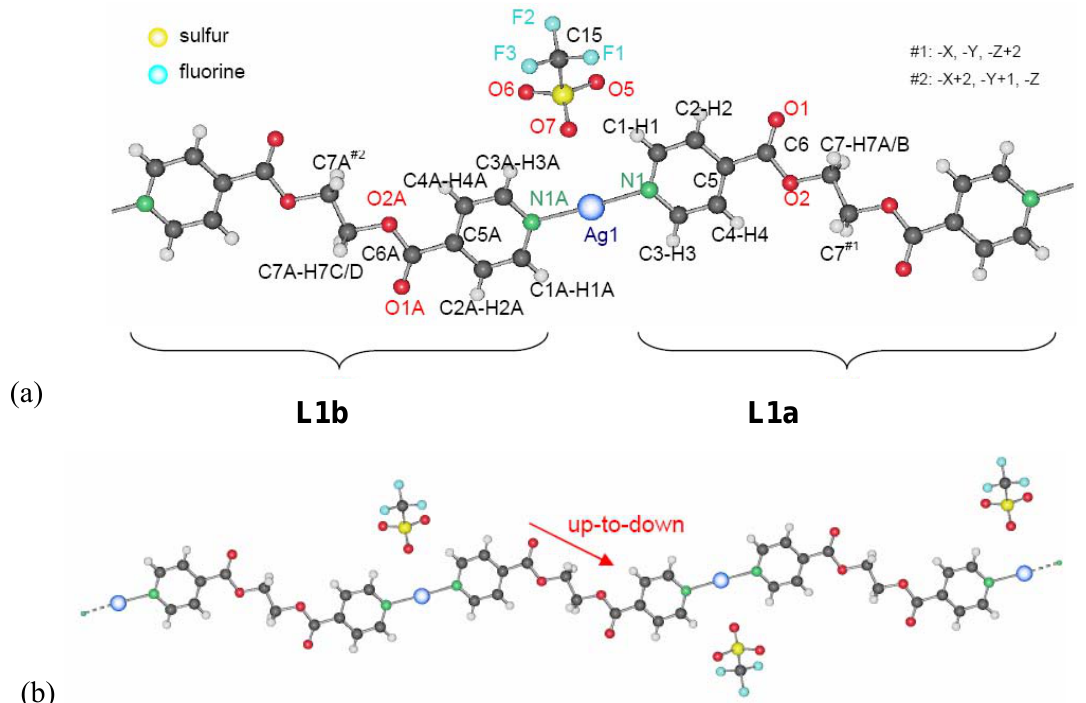
Figure 6. (a) Excerpt of the one-dimensional chain structure of 7 and numbering;